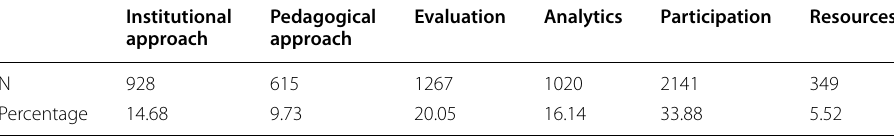
Table 2 MOOCs literature thematic Groups: production of papers